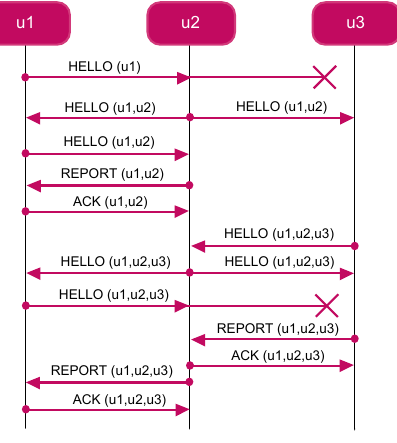
Figure 5. An execution instance of